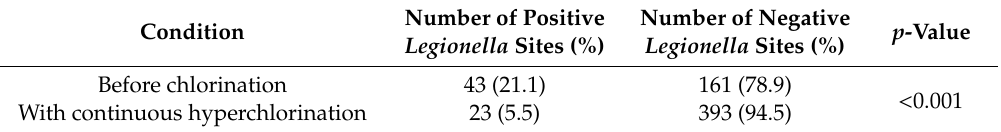
Table 2. Comparison of Legionella positivity before and after chlorination. Adapted from [80].